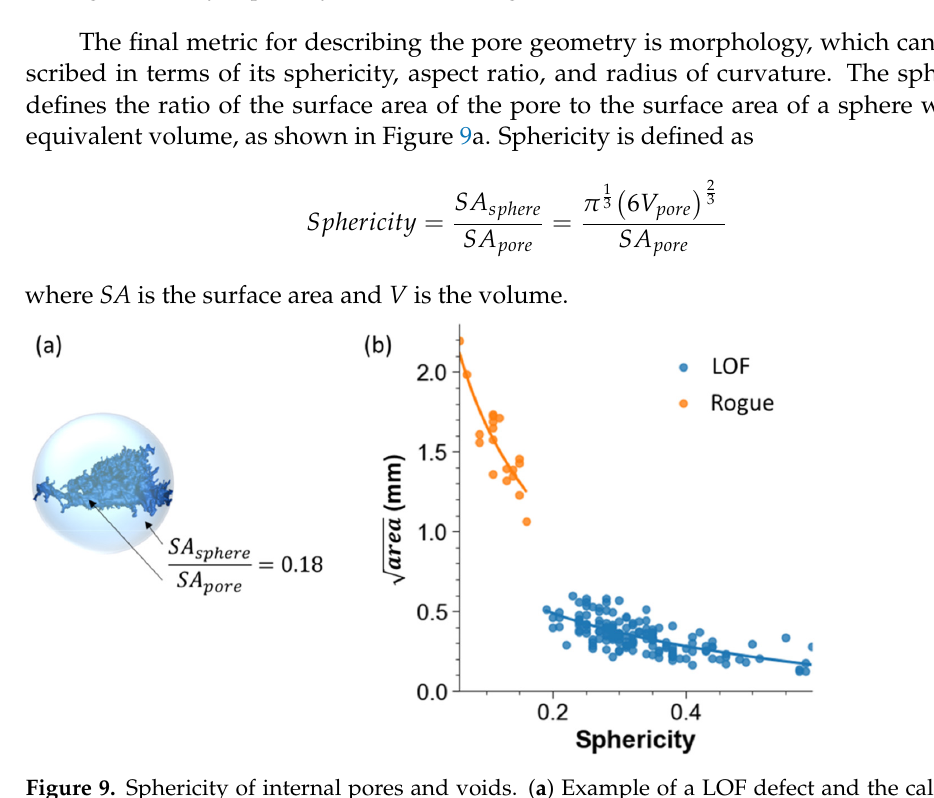
√ area as a function of